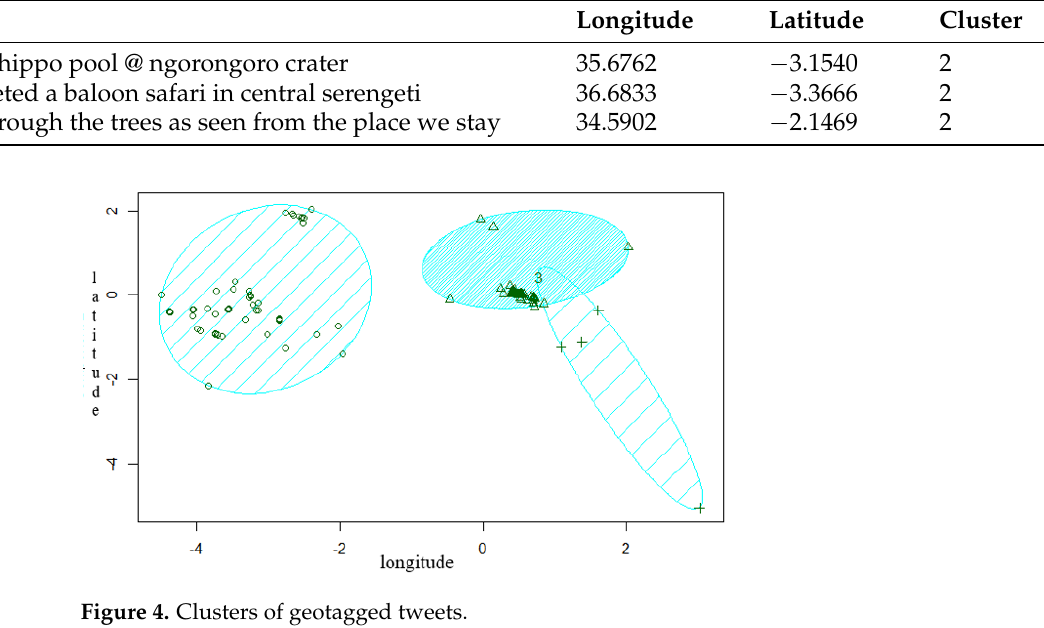
Figure 3. Number of clusters (K). Table 1. Examples of location-clustered tweets.